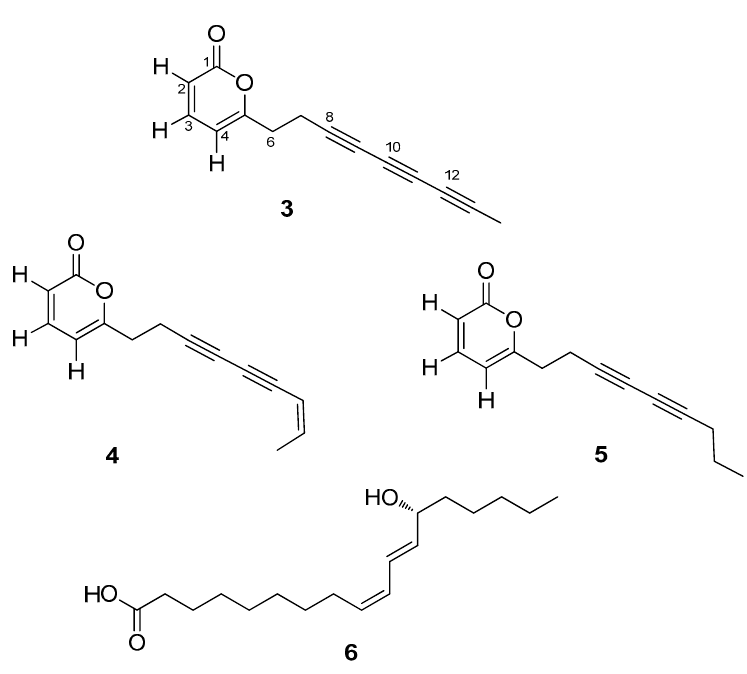
Figure 2. The chemical structures of 3 – 6 , isolated from E. platyloba.